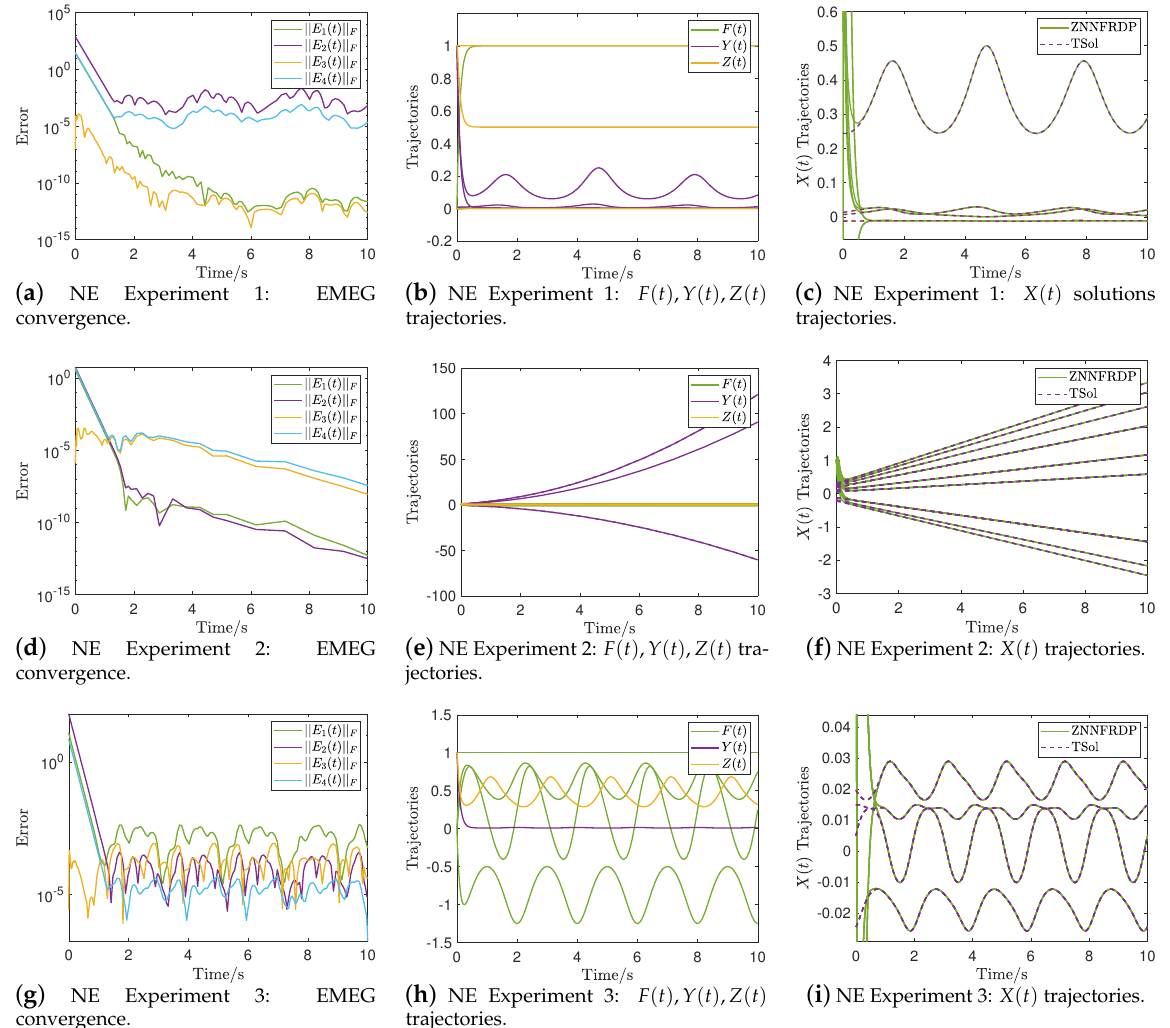
Figure 2. EMEG convergence and solutions’ trajectories of the ZNNFRDMP model in NEs in Sections